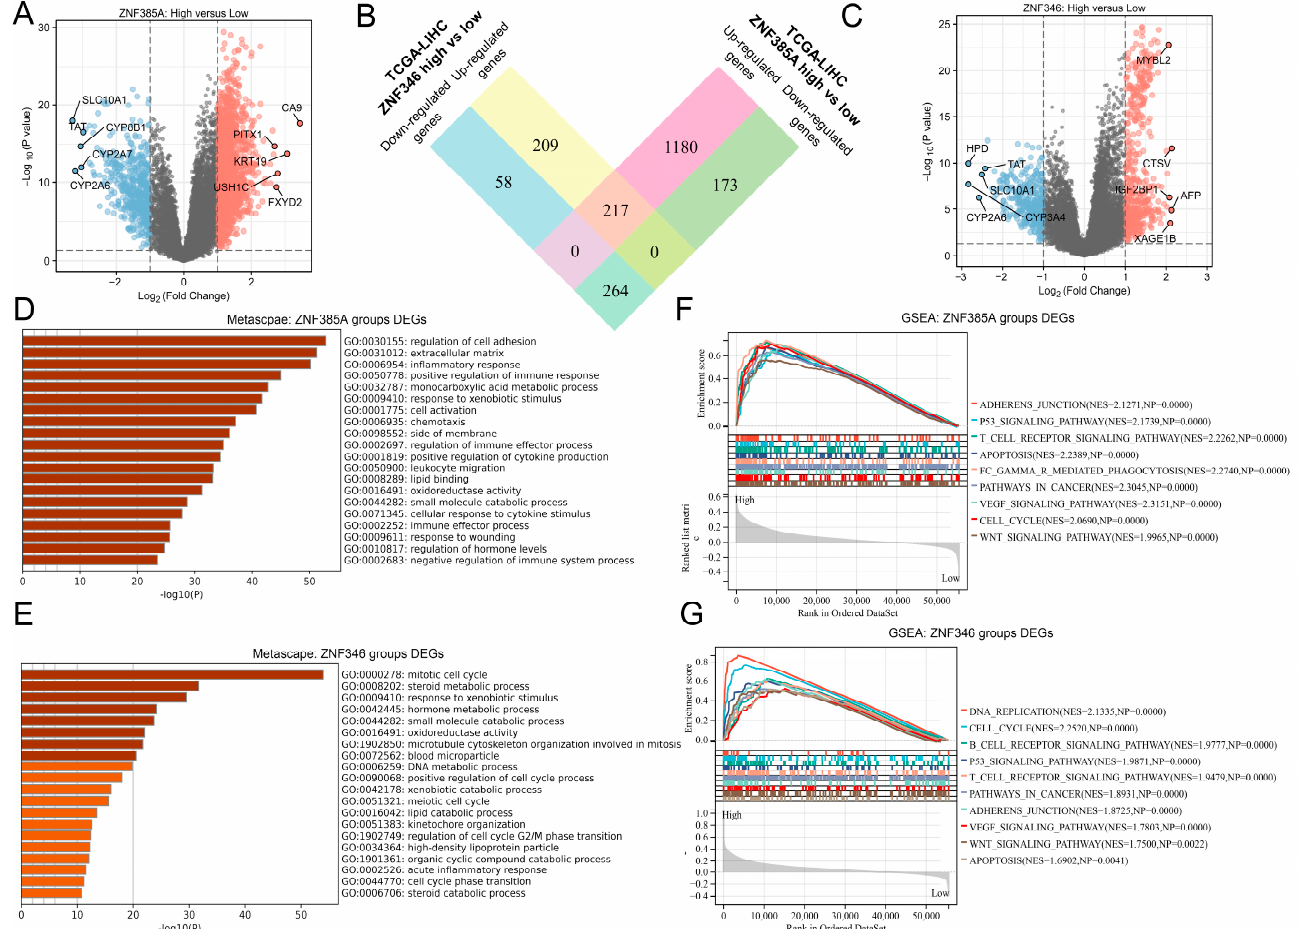
Figure 4. Function and pathway enrichment analyses of ZNF385A and ZNF346 in HCC. ( A ) A volcano plot of ZNF385A -related DEGs in HCC, top 5 up- or down-regulated genes are visualized. ( B ) A Venn diagram showing ZNF385A and ZNF346 intersecting DEGs ( C ) A volcano plot of ZNF346 -related DEGs in HCC, top 5 up- or down-regulated genes are visualized. ( D , E ) GO enrichment analyses for ZNF385A - ( D ) and ZNF346 - ( E ) related DEGs. ( F , G ) GSEA enrichment analyses in ZNF385A ( F ) and ZNF346 ( G ) high expression